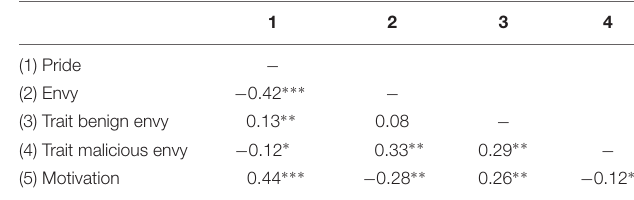
TABLE 1 | Correlations of emotions and